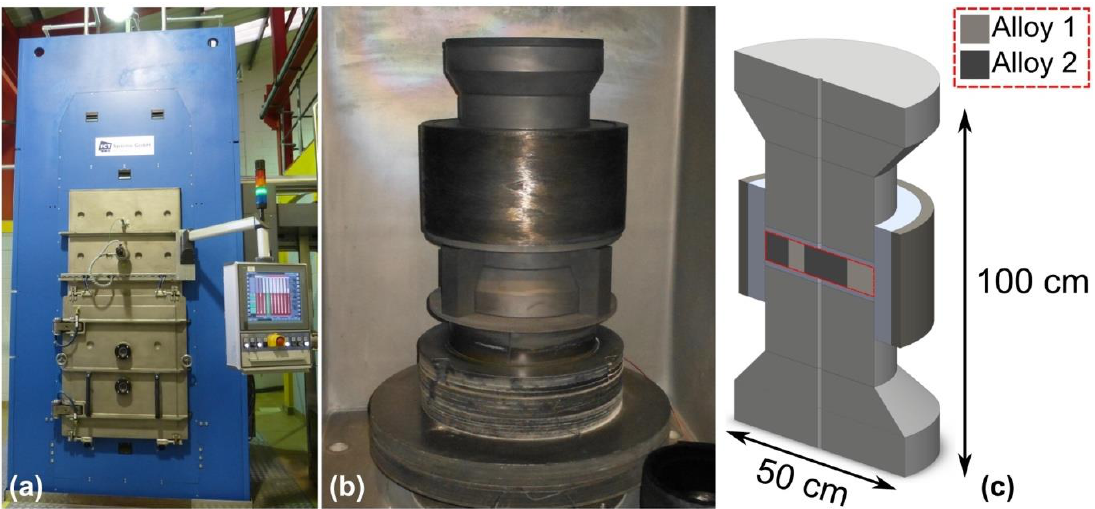
Figure 2. FAST-DB processing at the Kennametal Ltd. UK facility showing photographs of; ( a ) the FCT Systeme FAST processing machine; ( b ) the 250 mm inner diameter assembly consisting of graphite tooling and an outer woven carbon fibre jacket; and ( c ) the sliced CAD model of the aforementioned assembly showing the division of powders and the pyrometer hole passing through the tooling.